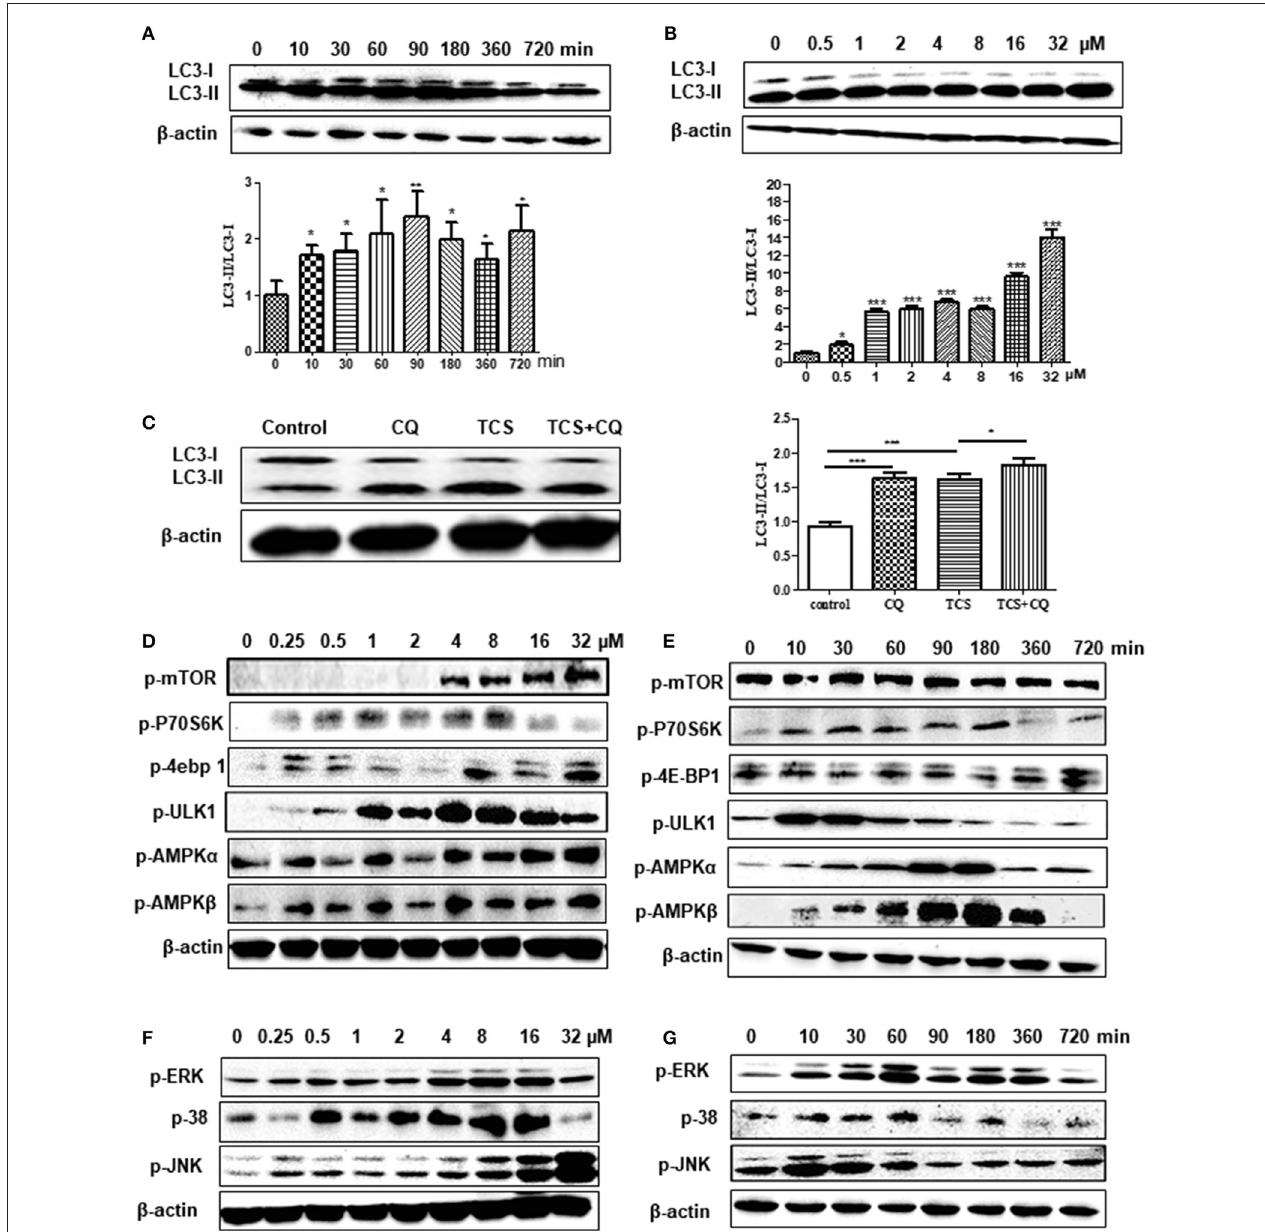
FIGURE 1 | TCS treatment induces an autophagic response in M 8 . RAW264.7 cells were treated with TCS (8 µ M) for different times ranging from 0 to 720min. Western blotting was used to assay the expression of LC3 (A) . RAW264.7 cells were treated with TCS at different doses ranging from 0.5 to 32 µ M for 90min. Western blotting was used to assay the expression of LC3 (B) . RAW264.7 cells were pretreated with or without CQ (25 µ M, 60min) and were then treated with or without TCS (8 µ M) for 90min. The results was assayed by western blot (C) . RAW264.7 cells were treated with TCS at concentrations ranging from 0.25 to 32 µ M for 90min. The levels of phosphorylation of mTOR, p76S6K, 4E-BP1, AMPK- α , AMPK- β , and ULK1 (D) or JNK, ERK, and p38 (F) were assayed by western blot. RAW264.7 cells were treated with TCS (8 µ M) for different times ranging from 0 to 720min. The levels of phosphorylation of mTOR, p76S6K, 4E-BP1, AMPK- α , AMPK- β , and ULK1 (E) or JNK, ERK, and p38 (G) were assayed by western blot. Compared to the respective controls, * p < 0.05, ** p < 0.01, *** p < 0.001.